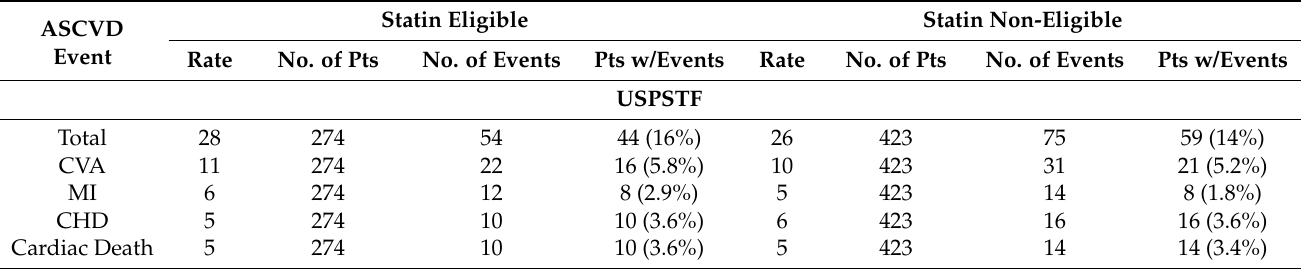
Table 4. Event rate per 1000